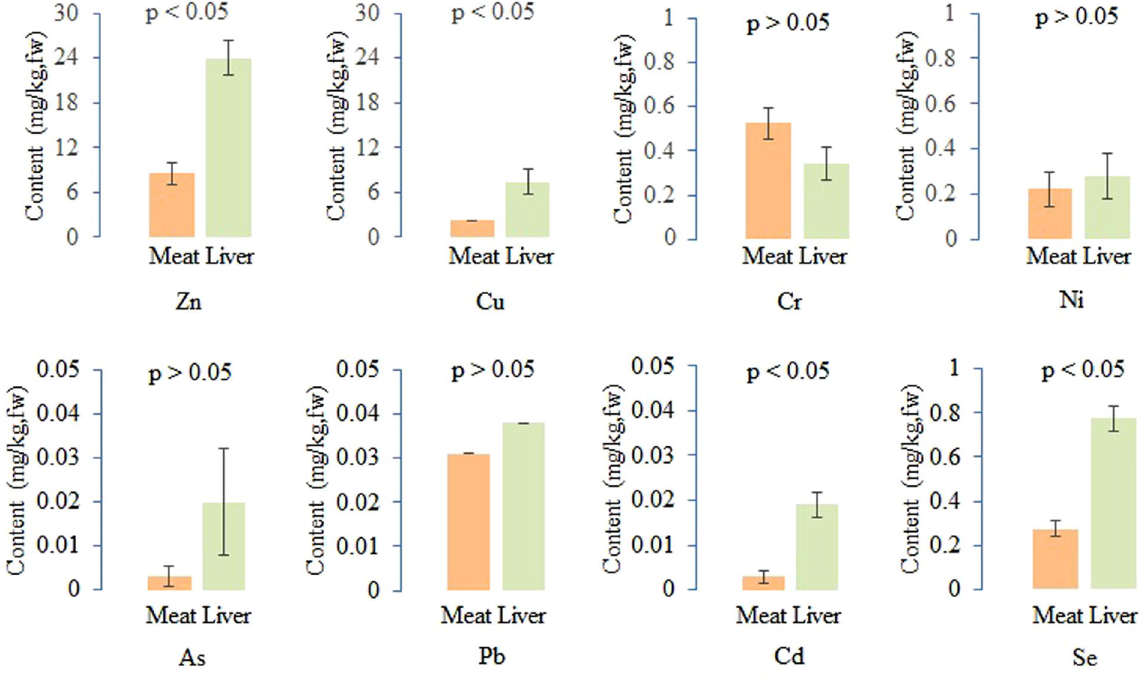
Figure 4. Heavy metal concentrations in the meat (chest muscle) and livers of chickens fed with 15% maggot meal harvested from swine manure. Data are presented as the means ± SEM (n = 3), and the p value represents the significant differences analysed with an ANOVA test.